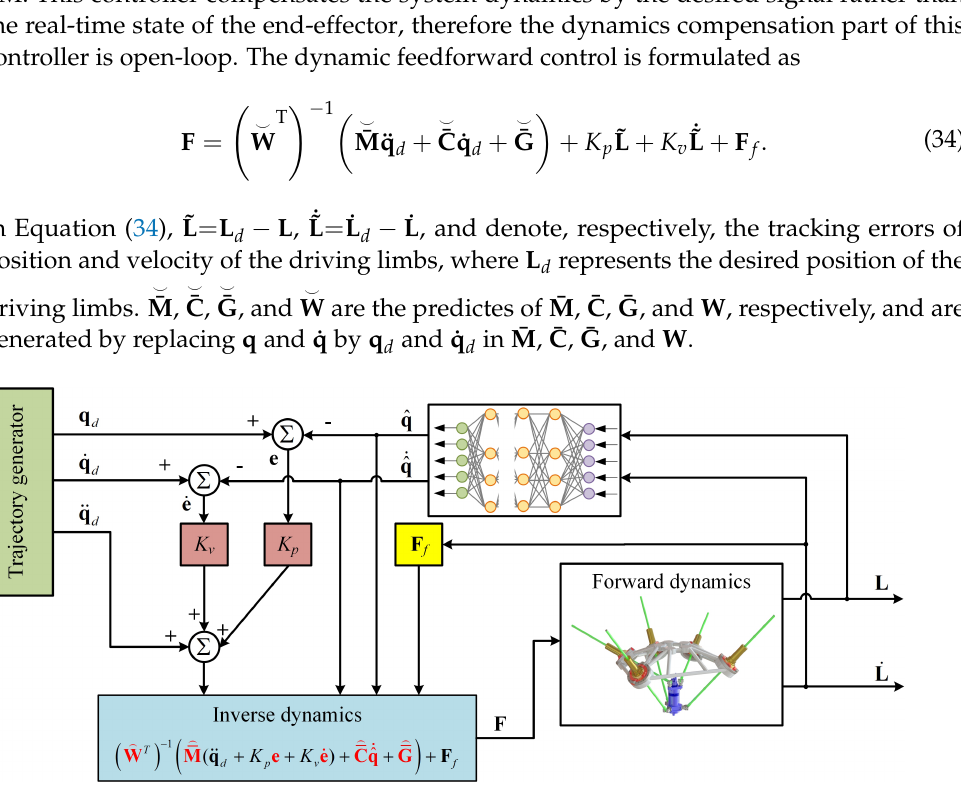
Figure 9. Block diagram of the proposed controller with DNN-based feedback